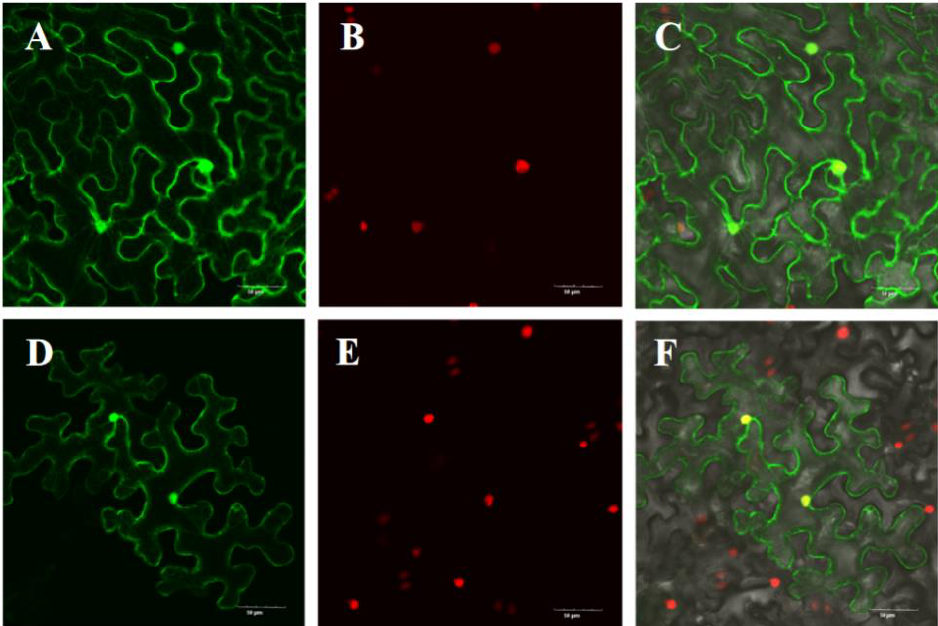
Figure 7. Subcellular localization of LsOVATE1 in N. benthamiana epidermal cells. Empty GFP vectors were used as controls, and showed green fluorescence. The tobacco nuclei showed red fluorescence. C and F are digitally merged images of both bright-field and fluorescent signals. ( A – C ) show the localization of empty GFP control vector; ( D – F ) show the localization of LsOVATE1 . Scale bar = 50 µM.